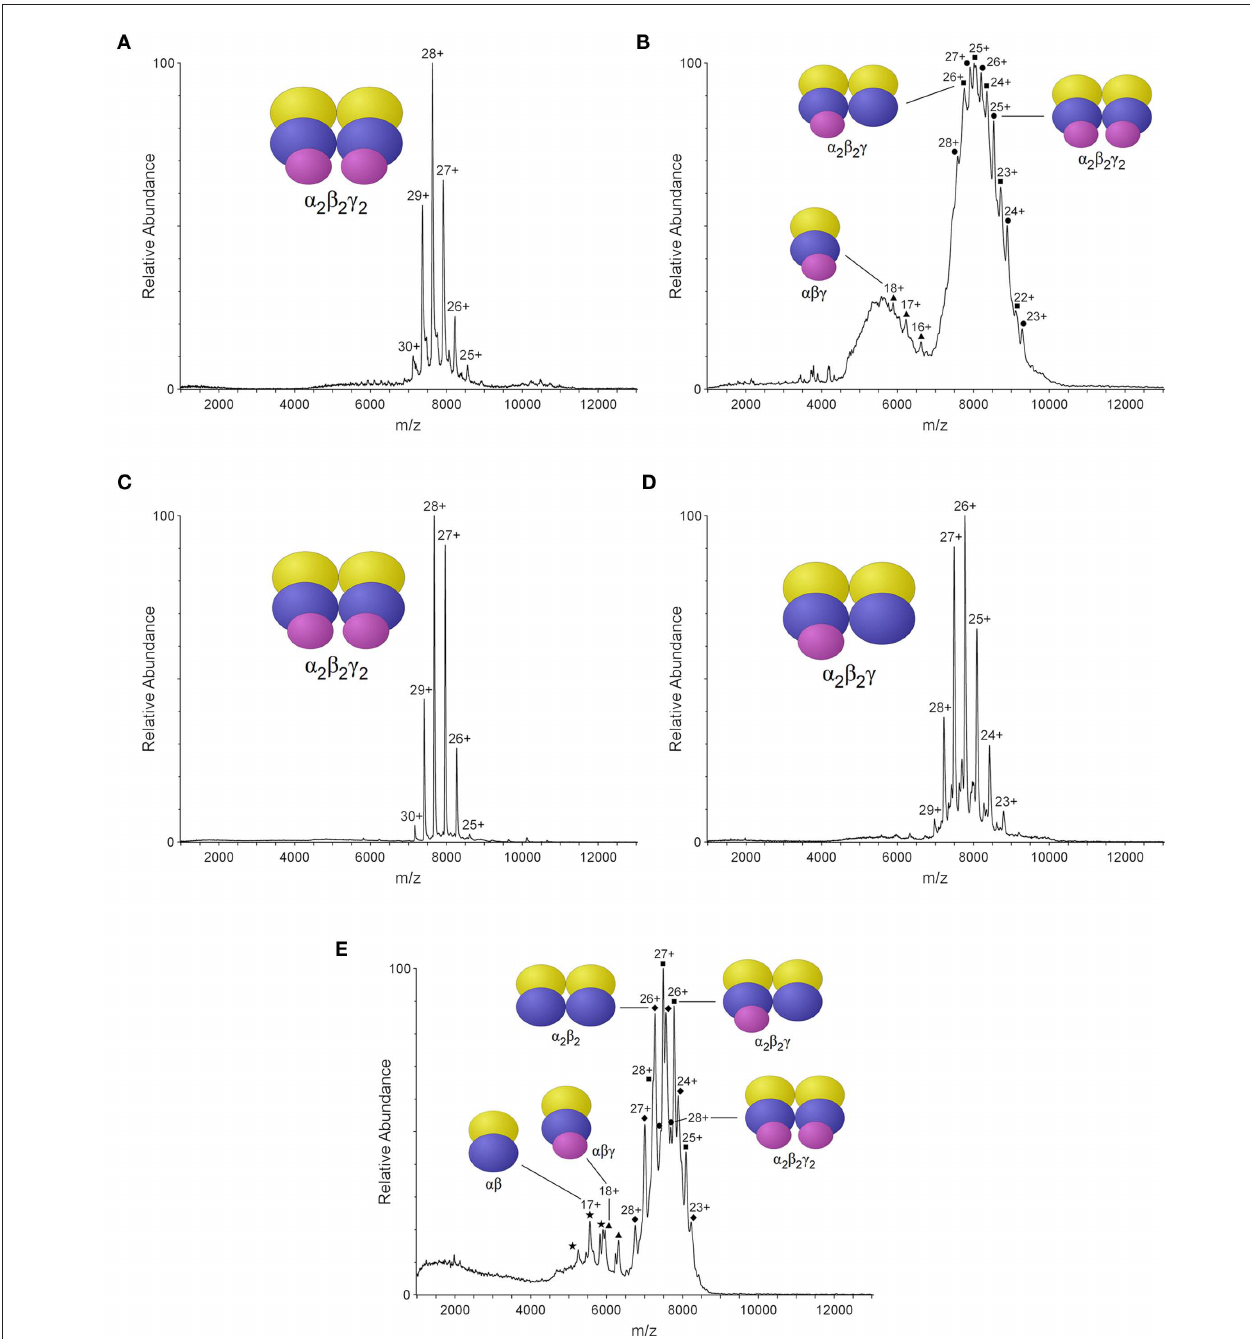
Figure 5 | Nano-eSi/MS spectra of the purified dSirs bands after native gel electrophoresis; D. vulgaris Dvir (A) band 1, (B) band 2; D. norvegicum (C) band 1, (D) band 2, and (e) band 3. Schematic representation of the different chains as ovals colored as in Figure